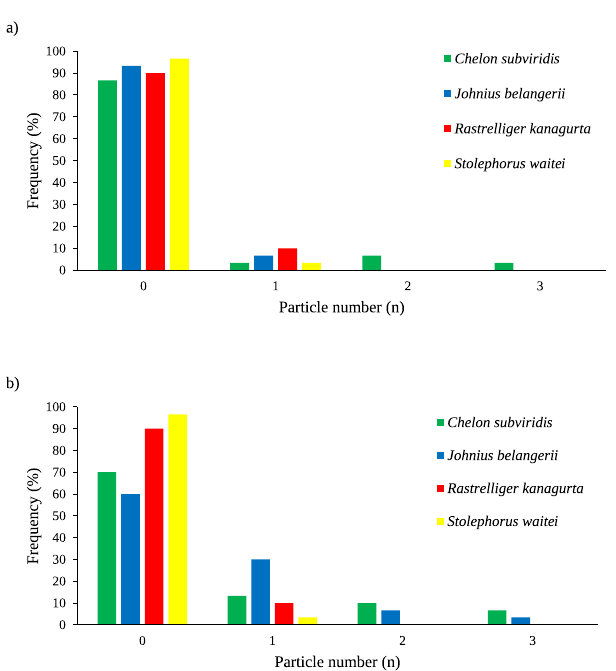
Figure 5. Frequency histograms of pigment and microplastic particles in the whole body (eviscerated flesh + excised organs) of tested dried fish species. Frequency histogram of ( a ) pigment and ( b ) microplastic particles in the whole body of Chelon subviridis , Johnius belangerii , Rastrelliger kanagurta , and Stolephorus waitei